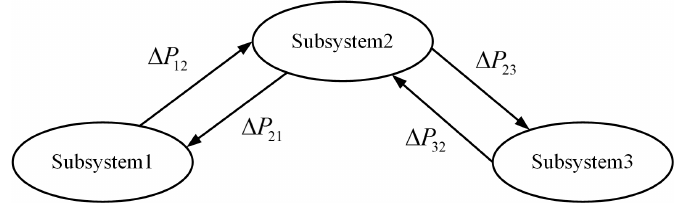
Figure 4. Power system structure for simulation